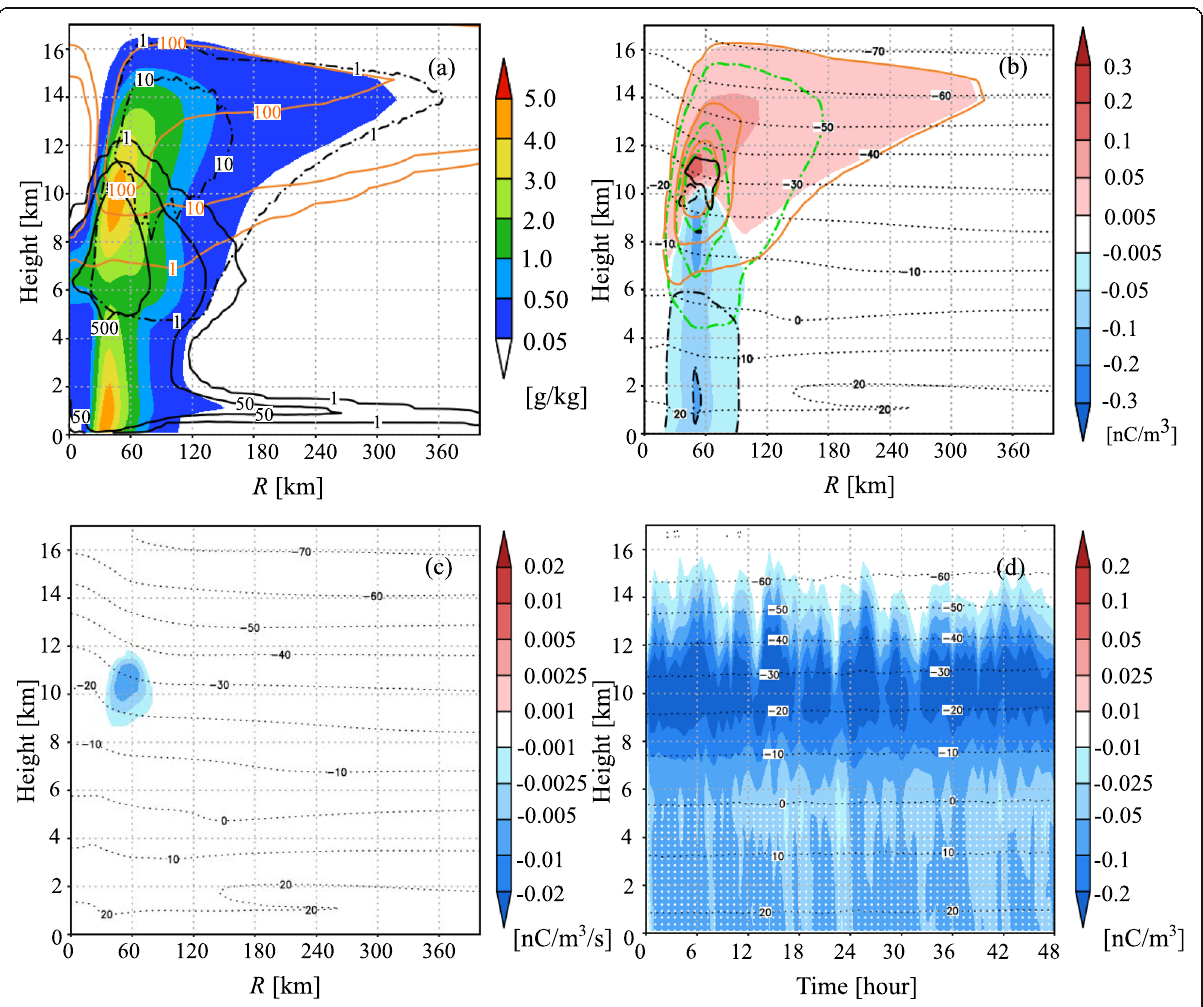
Fig. 8 a Number concentrations of water (black solid contour line; unit: cm − 3 ), ice and snow (orange contour line; unit: L − 1 ), and graupel (black dot-dashed line; unit: L − 1 ), and qhyd (shaded area). b Charge density of hydrometeors (shaded area), cloud and rain (black contour line), ice and snow (orange contour line), and graupel (green contour line). c Charge density rate added to graupel by non-inductive charge separation over the z – R plane simulated and d temporal evolution of the charge density of graupel tangentially averaged over 20 km < R < 80 km with N 0 = 1000 cm − 3 . The white dotted area in d indicated the charge density of raindrops. The dotted line in b – d indicates temperature (°C). Solid and dash-dotted contours in b show positive and negative charge charge densities, respectively. The contour lines in b show 0.01, 0.1, and 0.3 nC m − 3 , respectively. The variables were tangentially averaged during the last 12 h of the